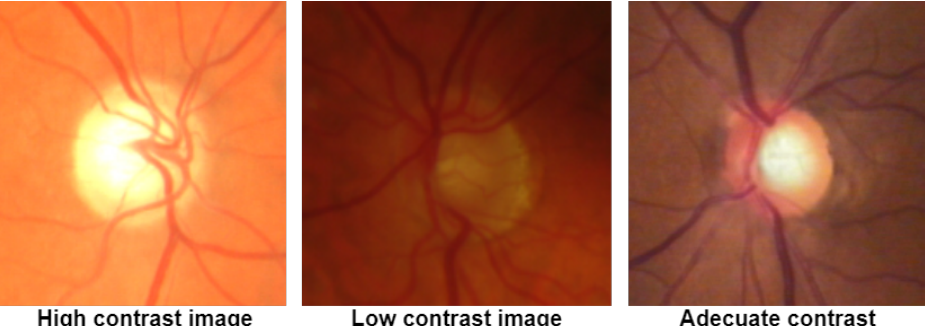
Figure 10. Comparison between high, low and adequate contrast images to be classified by the